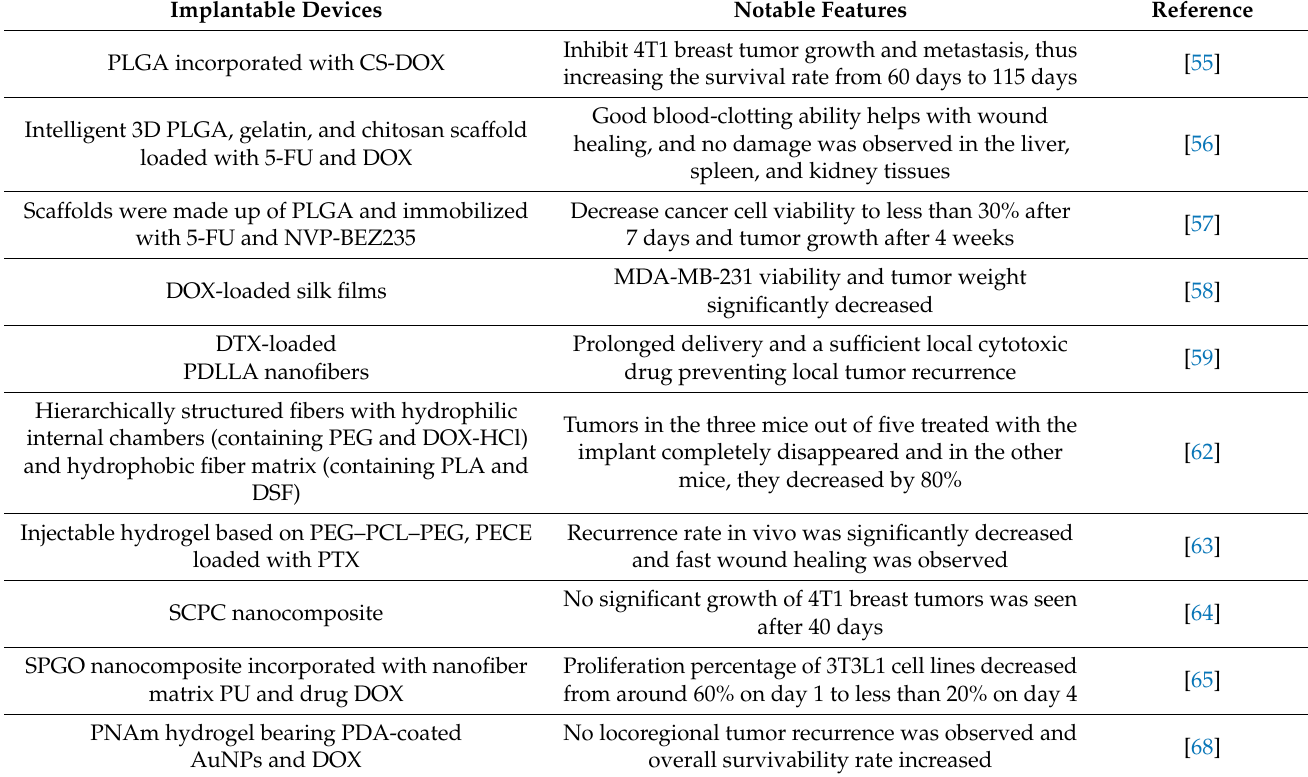
Table 2. Types of implantable devices for breast cancer